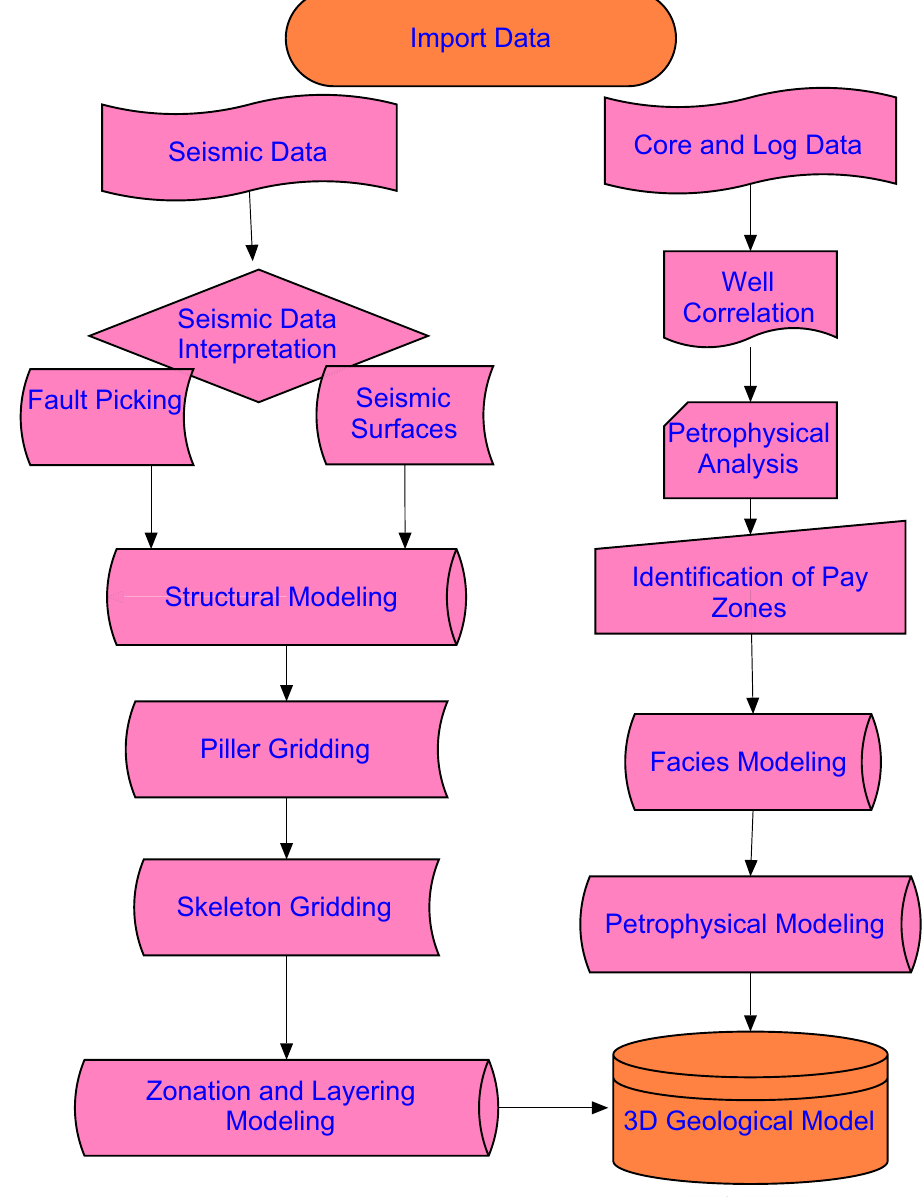
Fig. 2 Flowchart of the